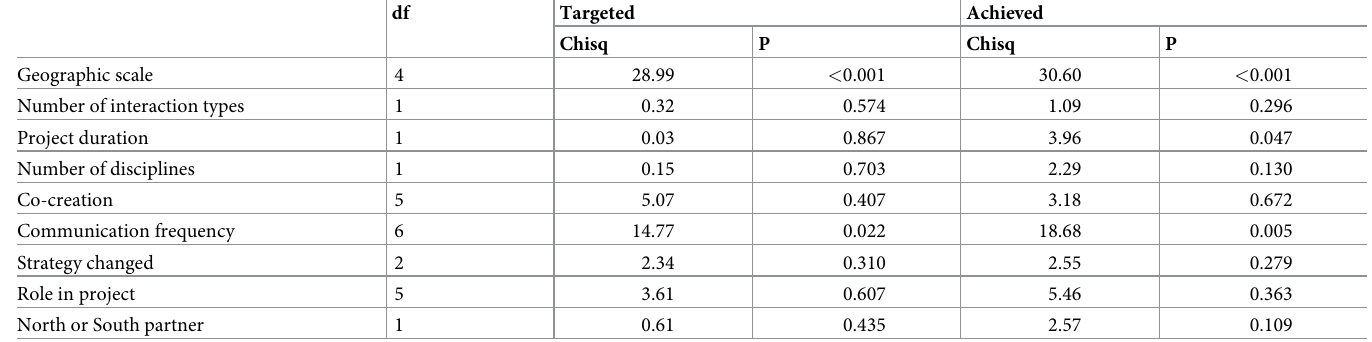
Table 3. Analysis of deviance table (type II Wald chisquare tests) indicating significance of different factors on the mean level of targeted and achieved RKU (left and right, respectively). df